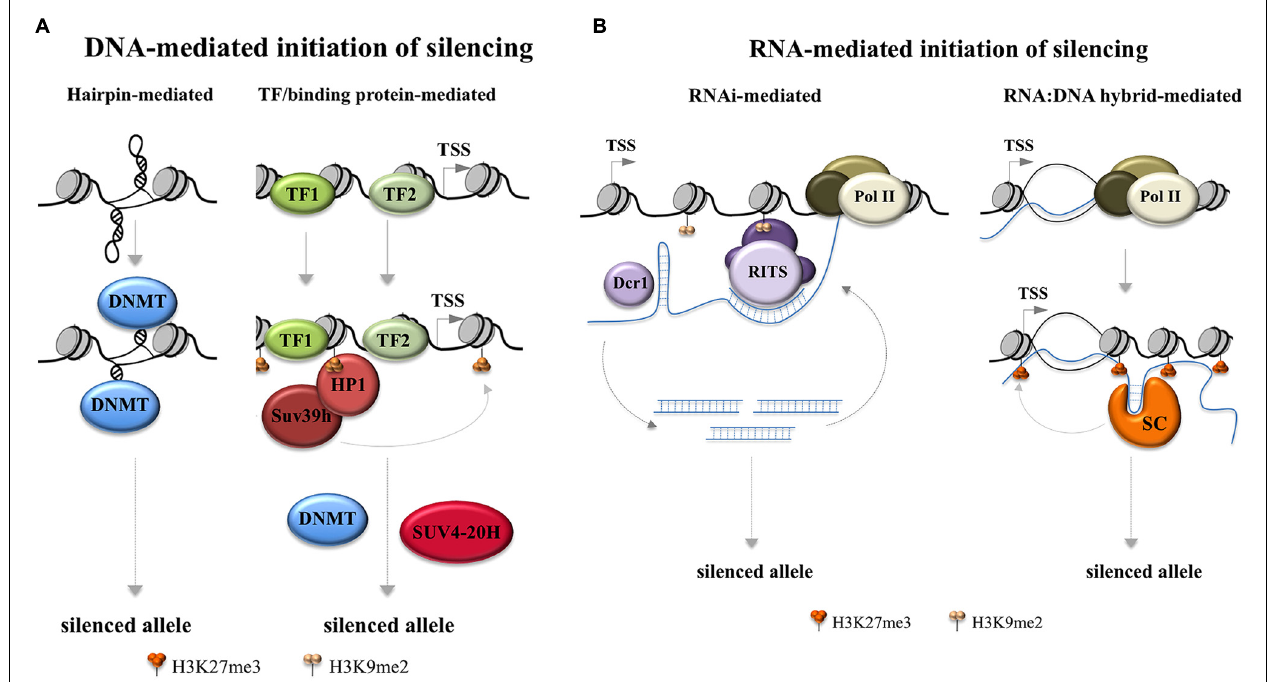
the small Dicer products to the FMR1 mRNA would occur via the same combination of Hoogsteen and Watson–Crick base pairing that generates the RNA hairpins in the first place. Alternatively, the duplex RNAs could be generated by base pairing of FMR1 mRNA with an antisense transcript generated from this region (Ladd etal., 2007). The RNA-induced transcriptional silencing (RITS) complex, which includes the argonaute family member AGO1, then could mediate heterochromatin formation by associating with nascent transcripts via base pairing with the Dcr products. AGO1 could then recruit other epigenetic modifiers including members of the Polycomb (PcG) Group Complexes including EZH2 as suggested by work in human cells (Kim etal., 2006). The right hand panel depicts a way in which an RNA:DNA hybrid may initiate silencing by tethering the FMR1 transcript to the FMR1 locus while also recruiting silencing complexes (SC) that bind to the repeat, perhaps to the secondary structures formed by the repeat, analogous to what has been reported for the RASSF1A locus (Beckedorff etal., 2013) and for ribosomal DNA repeats and IAP elements (Bierhoff etal., 2014). Dcr1: Dicer 1; Pol II: RNA Polymerase II; RITS: RNA interference (RNAi) effector complex; SC: silencing complex; TSS: transcription start